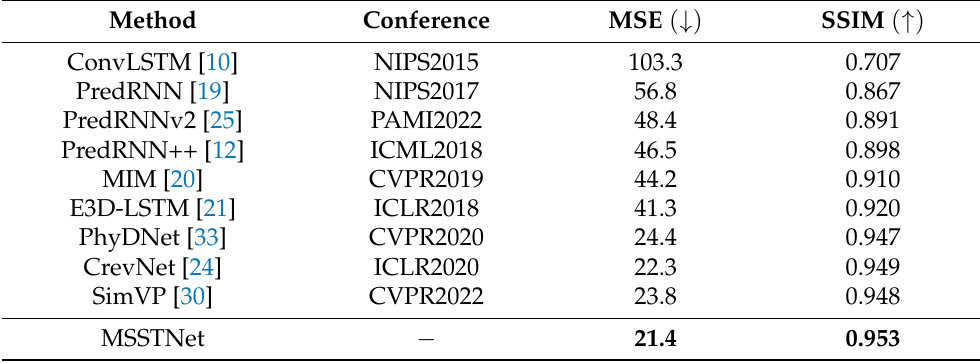
Table 5. Comparison of evaluation indices of various methods in MovingMNIST. ↓ ( or ↑ ) means lower (or higher) is better. The optimal results are marked by bold